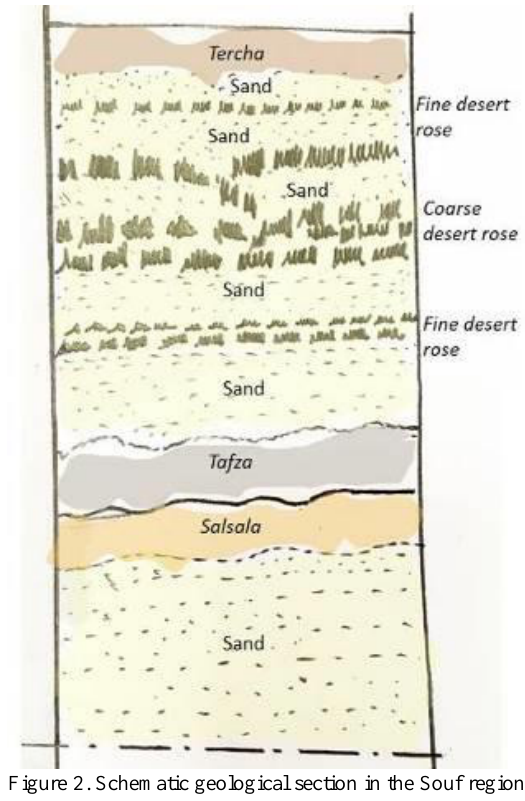
Figure 2. Schematic geological section in the Souf region.